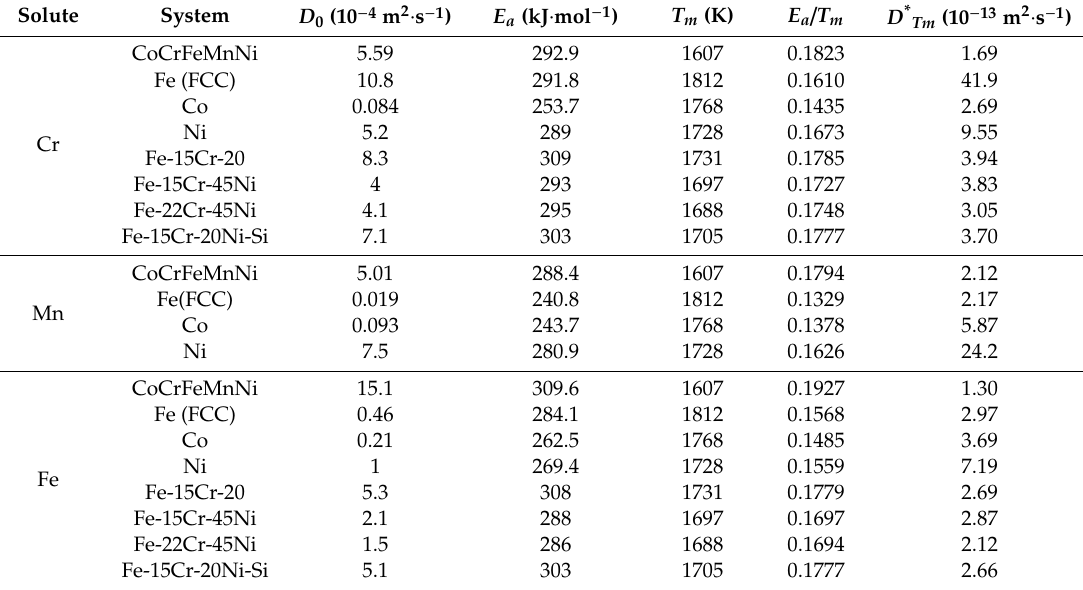
Table 4. Di ff usion parameters for Cr, Mn, Fe, Co, and Ni in di ff erent matrices [28,57,58]. Table 4. Diffusion parameters for Cr, Mn, Fe, Co, and Ni in different matrices [28,57,58]. Solute